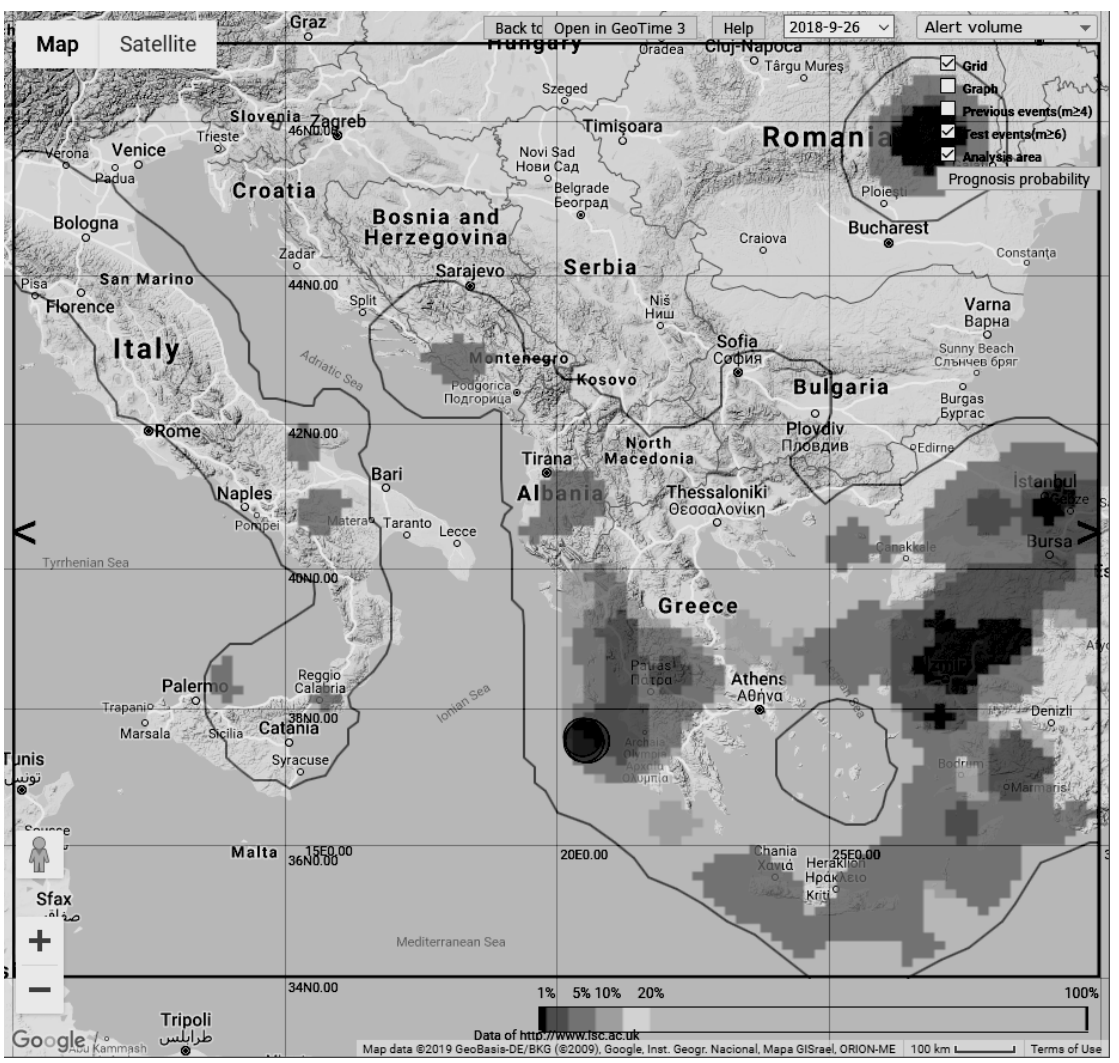
Figure 5. Screenshot of the web-based platform working window in the Mediterranean region: The map shows the alarm zone for earthquakes with a magnitude M ≥ 6.0 and the predicted epicenters of earthquakes of 25 October 2018 with a magnitude of 6.6 and 30 October 2018 with a magnitude of 6.2 calculated for training according to data up to 26 September 2017. The palette shows areas with different alarm volumes in percent: 1%, 5%, 10%, 15%,